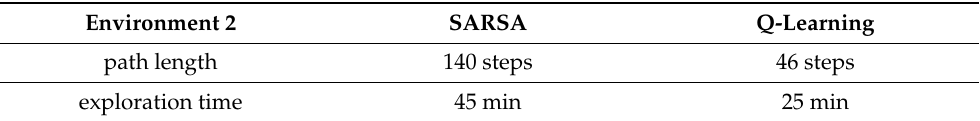
Figure 30. The Q-table of Q-learning and SARSA in Environment 2. Table 3. The results compared for Environment